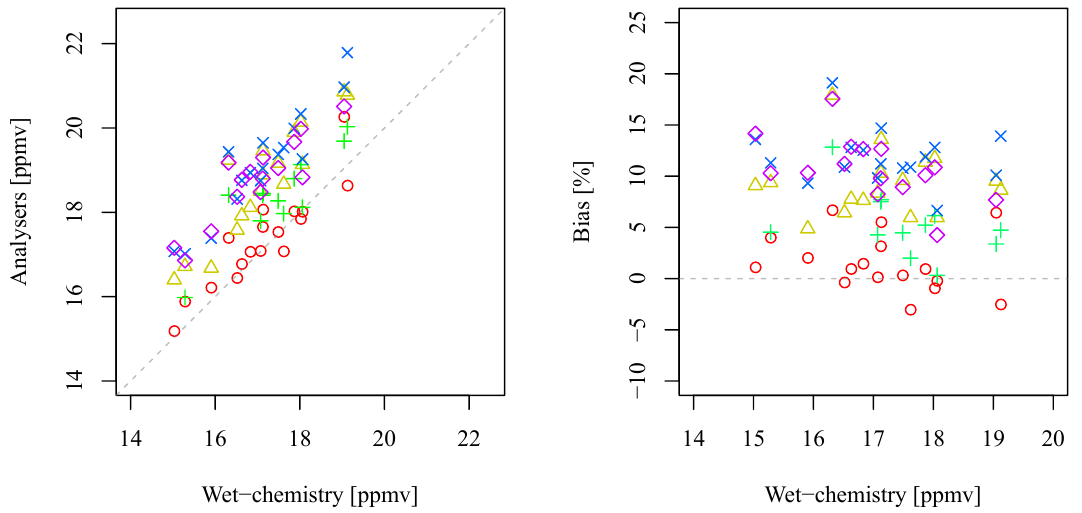
Figure 3. The scatter plot ( left ) and relative bias ( right ) between the wet-chemistry method and five gas analyser ( ◦ INNOVA, (cid:52) Picarro, + Rosemount, × Axetris, (cid:5) Gasmet) measurements on ammonia (NH 3 ) in a pig barn. The dashed line denotes 1:1